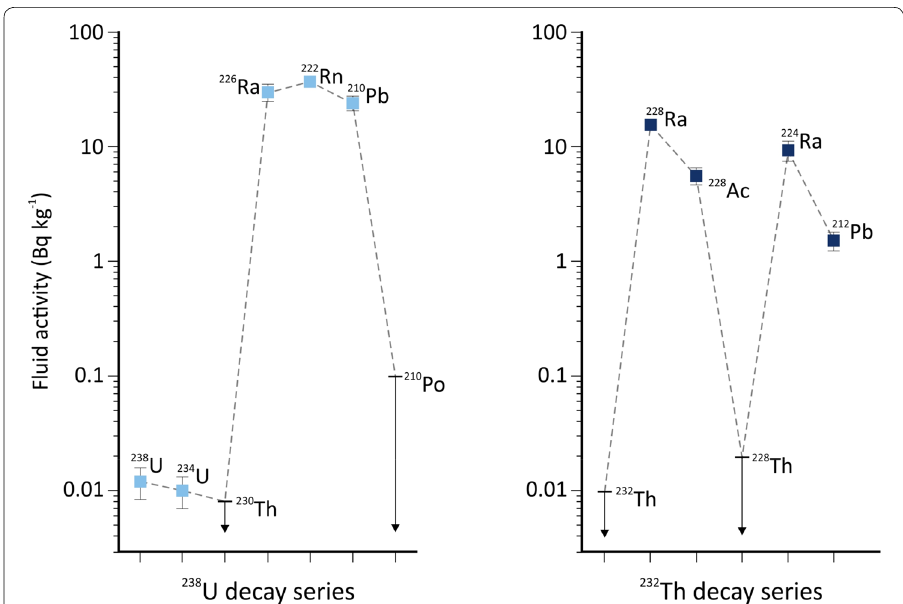
Fig. 4 Uranium and thorium series disequilibria: specific activity of 238 U and 232 Th and their decay products measured in the Bruchsal brine. Error bars represent uncertainties due to counting statistics ( 210 Po, 233 Th and 228 Th activities are upper limits. Radionuclide movement down the decay chain is from left to right